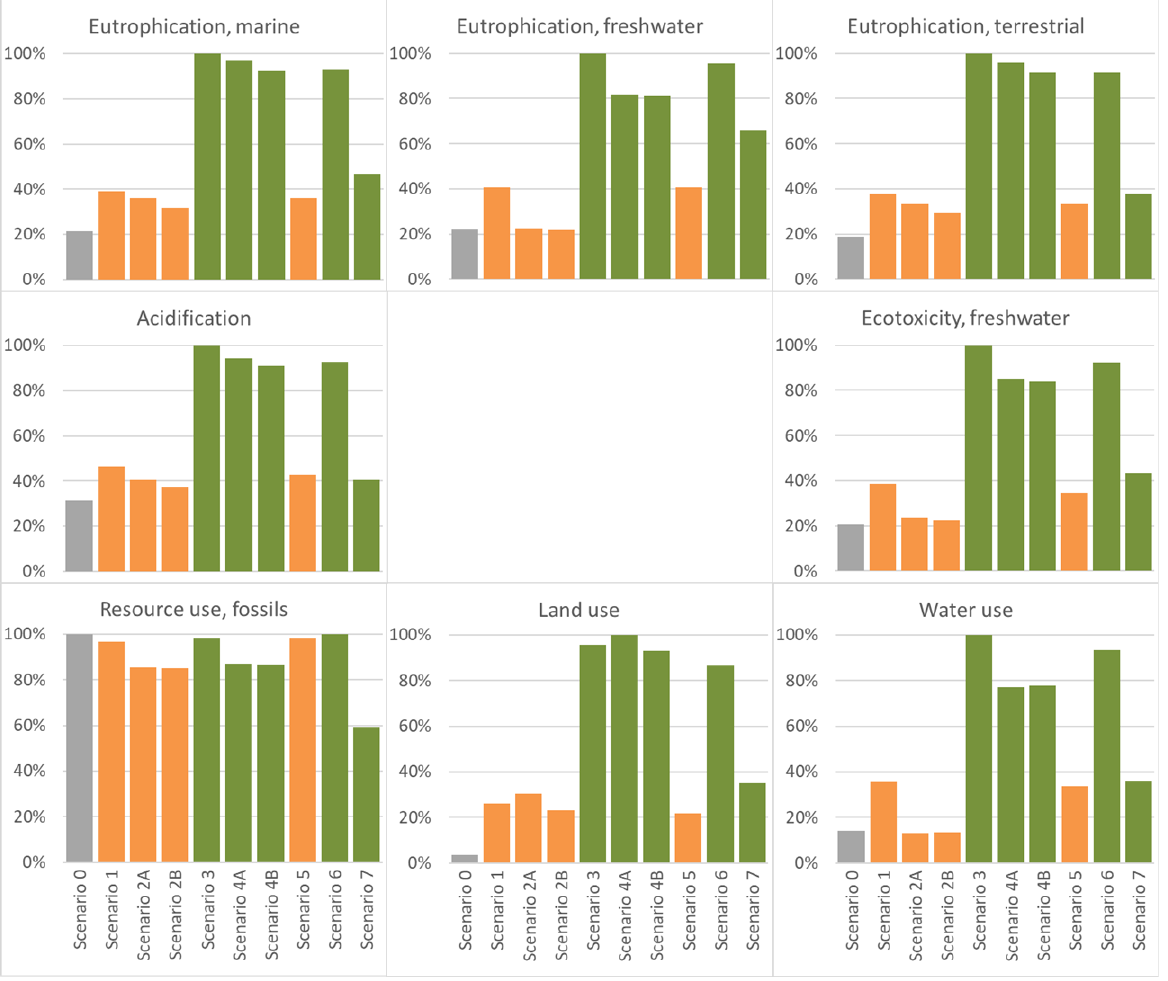
Figure 3. Impact results for 8 chosen categories calculated with Default EF . Note that 100% of each impact category refers to the scenario with the highest results.